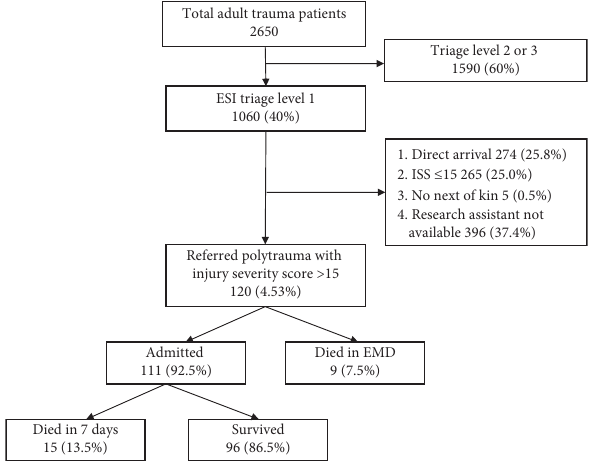
Figure 1: Flowchart of the trauma patient who presented at EMD, MNH, Dar es Salaam, Tanzania.